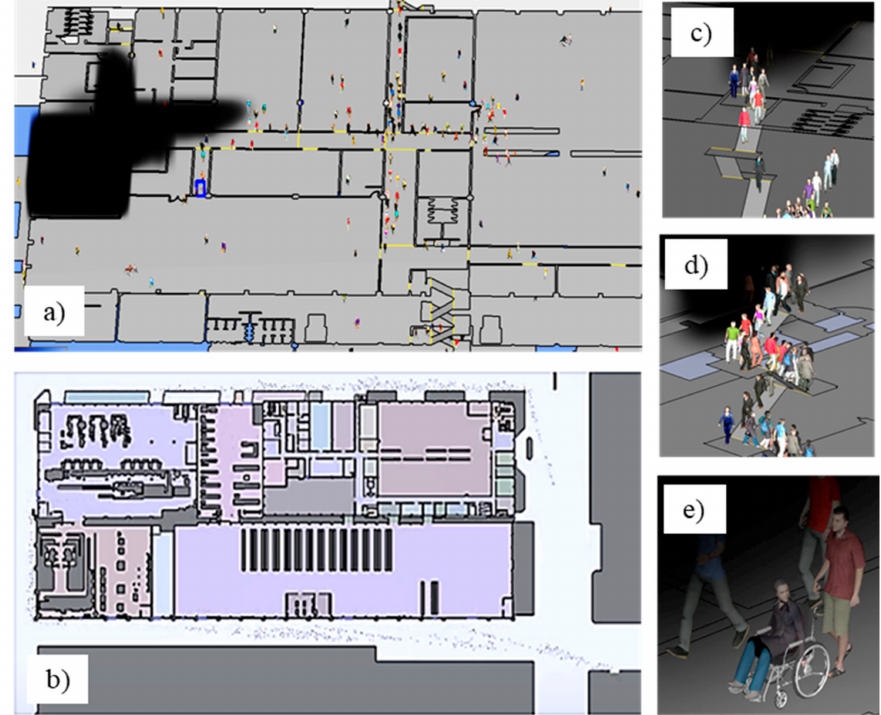
Figure 5. Agent evacuation ( a ) inside the building ( b ) outside the building ( c ) with door ( d ) with stair ( e ) with